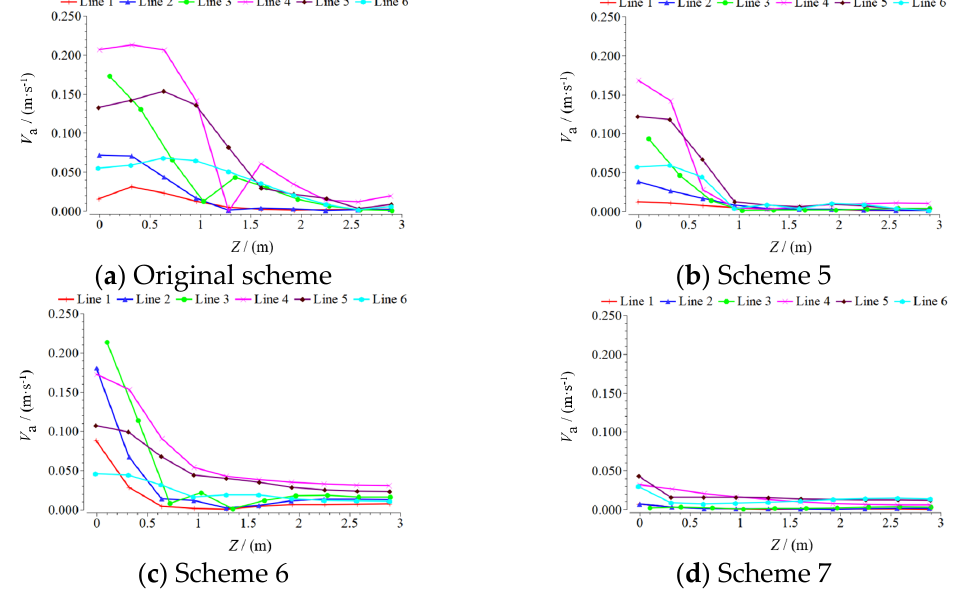
Figure 19. Diagram of axial velocity before the bell mouth in the sump 3#